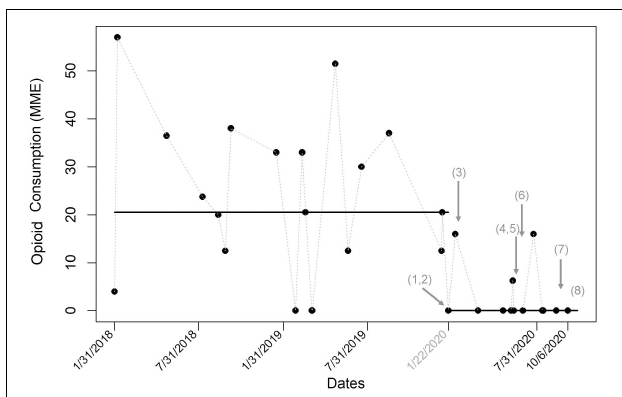
FIGURE 1 | Run chart for total oral morphine milligram equivalents (MME) in bone marrow donors ( N = 32). The line represents median MME. Multiple tests of change over time are noted with arrows. After implementing the protocol and quadratus lumborum (QL) block, administered MMEs significantly decrease. This decrease was maintained over time and through multiple tests of change, supporting the sustainability of the protocol. The tests of change included: (1) instituted QL blocks, (2) created anesthesia quality improvement champion, (3) standardized preoperative multimodal medications, (4) formalized perioperative protocol, (5) added anesthesia attendings to staff cases, (6) standardized intraoperative multimodal medications, (7) reduced postoperative oxycodone prescriptions, and (8) uploaded formal protocol to the anesthesia electronic medical record. BMT, bone marrow